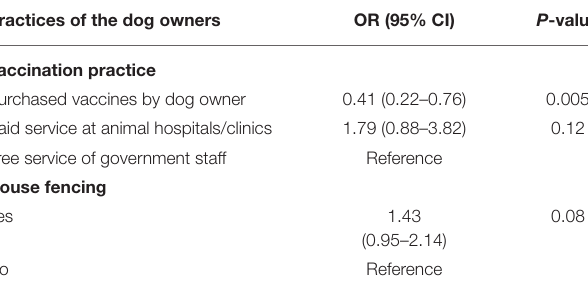
TABLE 4 | Determinants of the level of risk areas for rabies (high/low) in the logistic multivariable regression model regarding the practices of the dog owners ( n =